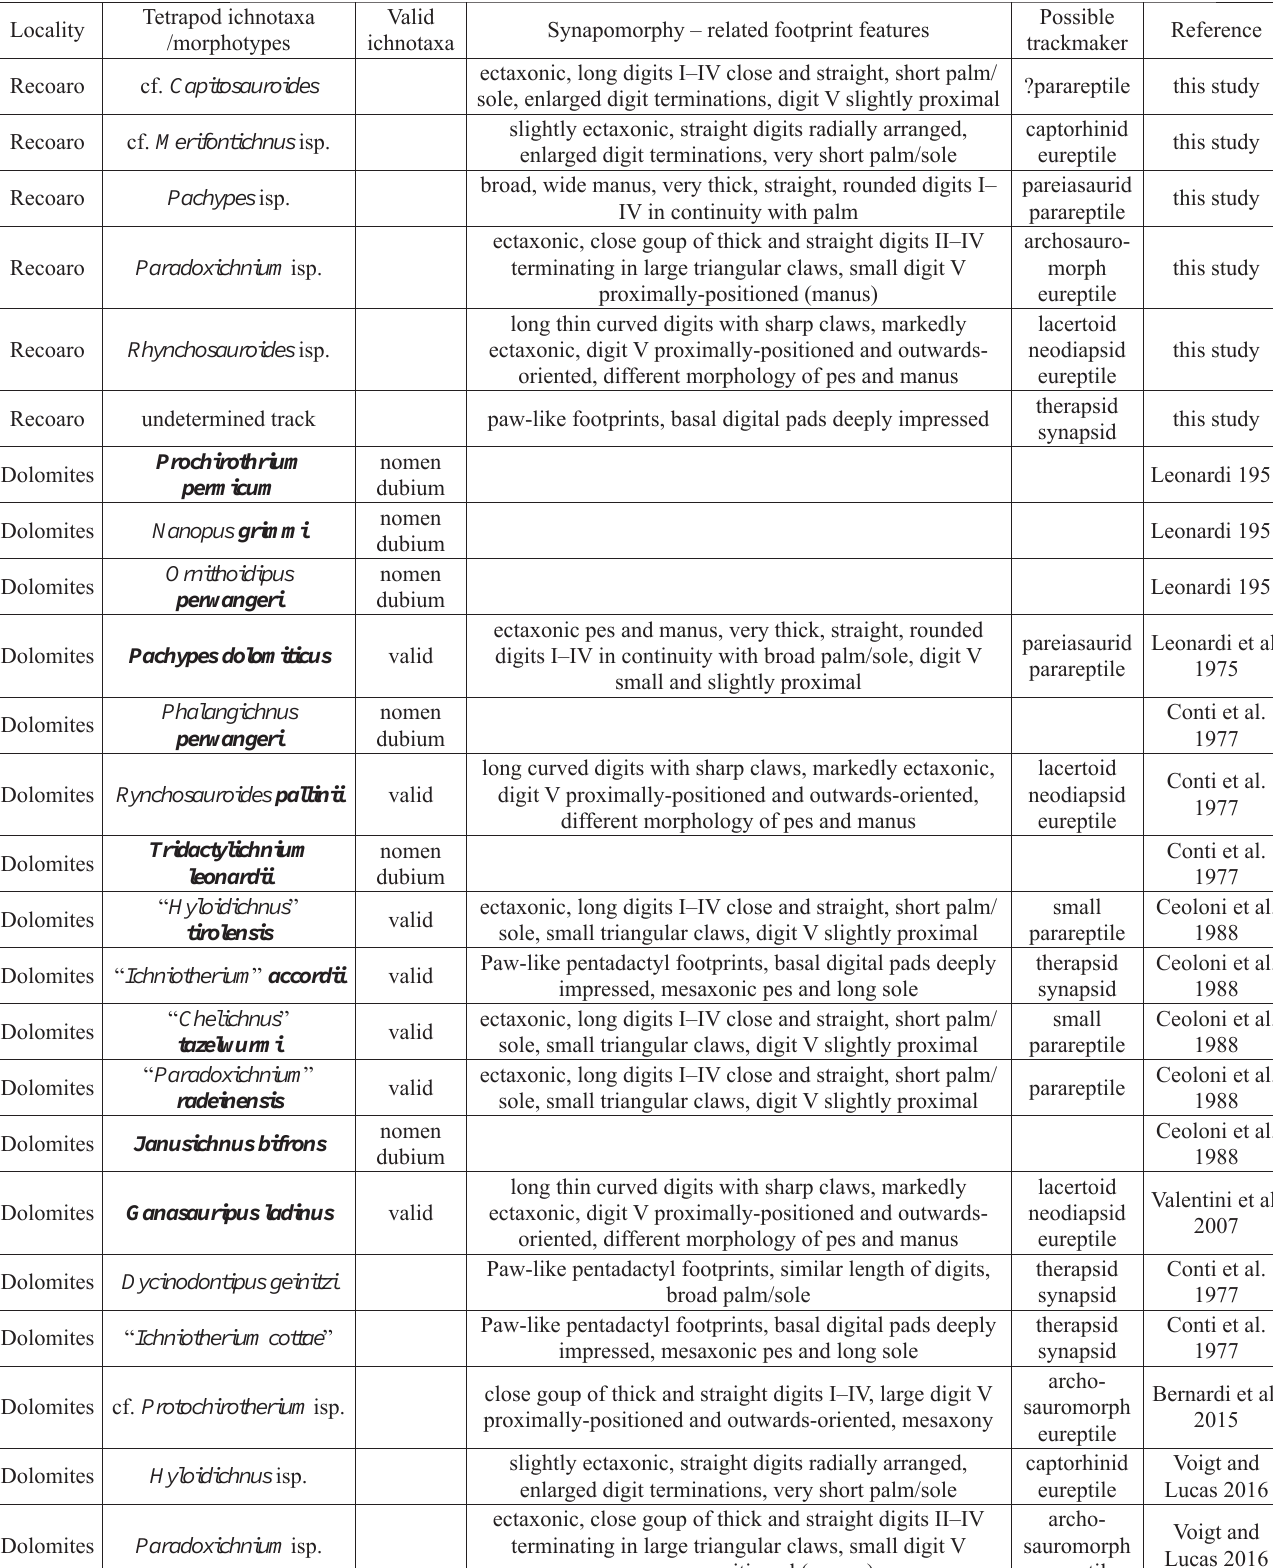
Table 2. Ichnotaxonomic status and possible attribution of the Lopingian tetrapod footprints from Italy (Val Gardena Sandstone; Recoaro and Dolomites). In bold ichnogenera and ichnospecies introduced from the Val Gardena Sandstone material. Valid ichno taxa applied only to the ich- notaxa introduced from the Val Gardena